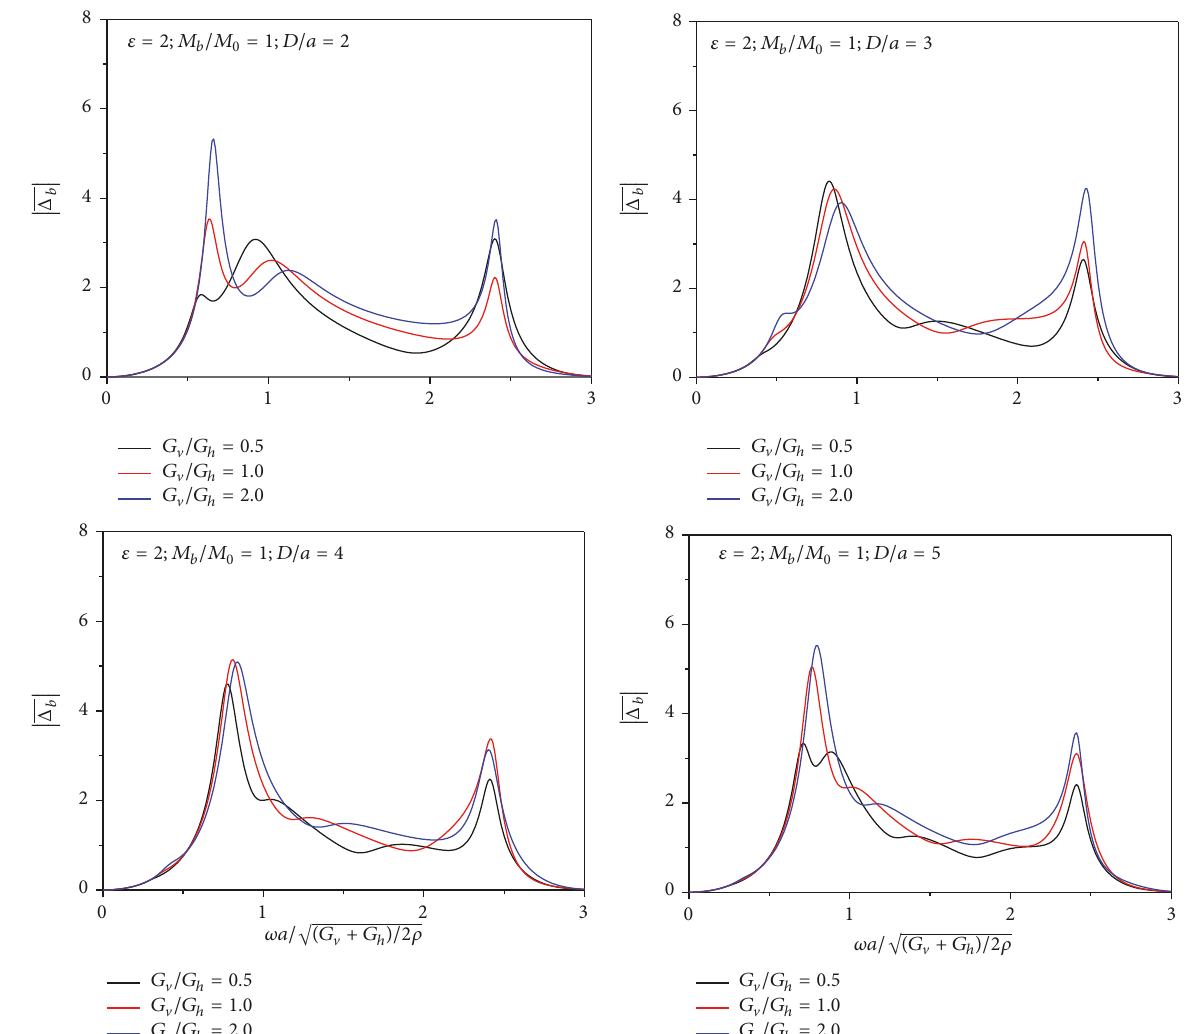
Figure 7: The superstructure response for different thicknesses of soil